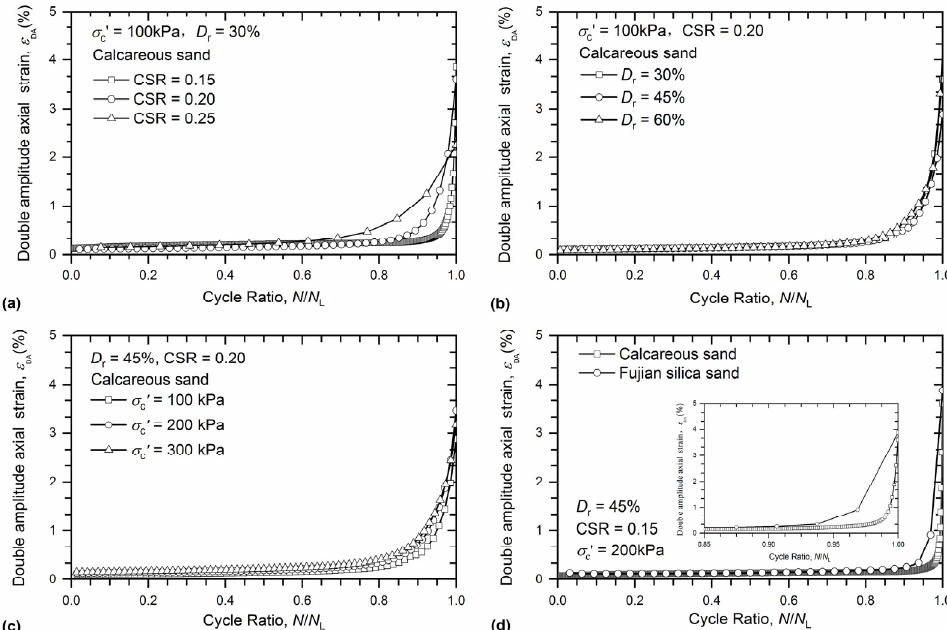
Figure 8. Comparison of double amplitude axial strain versus cycle ratio: ( a ) calcareous sand with different cyclic stress ratios, ( b ) calcareous sand with different relative densities, ( c ) calcareous sand with different effective confining pressures, ( d ) calcareous sand and Fujian silica sand with the same loading conditions.